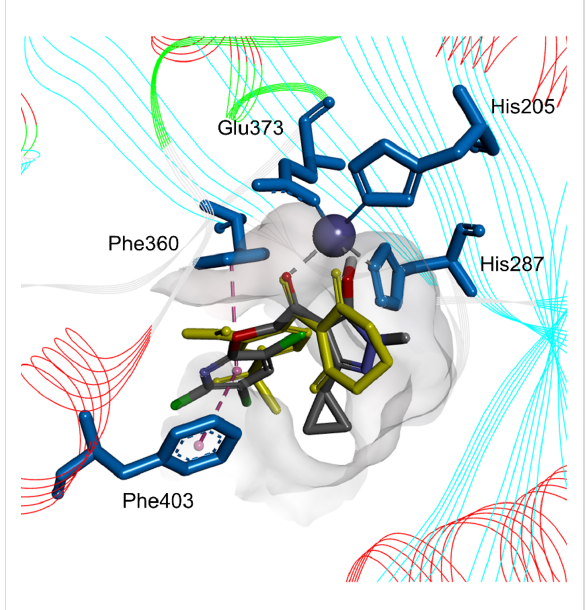
Figure 6: Simulated folding mode of mesotrione (yellow sticks) and compound II4 (gray sticks) with At HPPD. The key residues in the active site are shown in blue sticks, and Fe II is shown as a dark blue